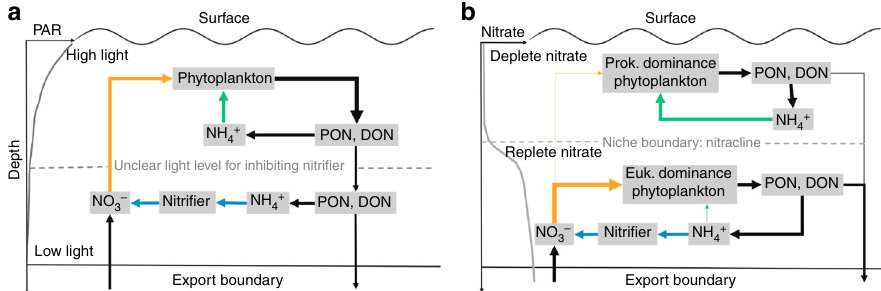
Fig. 5 Conceptual diagrams for the regulation of ammonium transformation pathways. a Conventional view: the control of the vertical distribution of NH 4 + assimilation and nitri fi cation in the euphotic ocean is separation by light: phytoplankton dominate NH 4 + consumption at high-light intensity, and reduced light inhibition enables nitri fi ers to dominate NH 4 + consumption at greater depth. However, the light level for inhibition shows large temporal-spatial variations and thus the niche boundary for nitri fi ers is unclear. b Amended view: ambient NO 3 − exerts important in fl uence on the competition for NH 4 + by nitri fi ers versus phytoplankton via determining phytoplankton community structure, and thus, the af fi nity of phytoplankton for NH 4 + . Above the nitracline, prokaryotes dominate, yielding higher af fi nity for NH 4 + ; while below the nitracline eukaryotes dominate and use the abundant NO 3 − as the main nitrogen source, reducing phytoplankton af fi nity for NH 4 + and enabling nitri fi ers to dominate ammonium recycling. Thus, the depth of the nitracline represents a predictable boundary for the bifurcation of the fate of ammonium. Blue arrows indicate nitri fi cation; green and orange arrows indicate NH 4 + uptake (regenerated production) and NO 3 − uptake (new production),